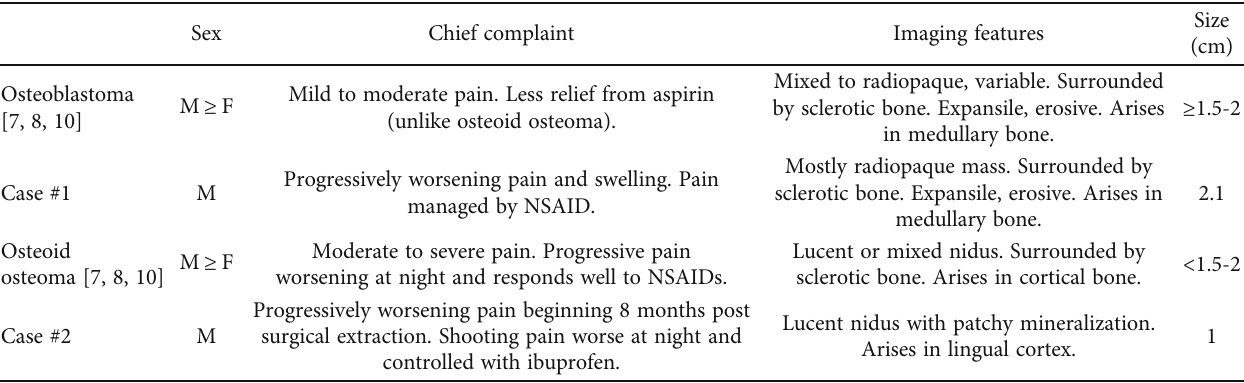
Figure 6: Histological features of case #1 (a and b). (a) Decalci fi ed bone with evident reversal lines with prominent osteoblastic activity. Note the vascular connective tissue stroma with dilated blood vessels and hemorrhage (H&E stain, × 40). (b) A higher magni fi cation of panel (a) showing the bone with prominent and large osteoblasts with abundant cytoplasm and epithelioid morphology (H&E stain, × 100). (c and d) Histological features of case #2. (c) Decalci fi ed bone with reversal lines with prominent osteoblastic activity. Note the vascular connective tissue stroma with dilated blood vessels and small foci of hemorrhage (H&E stain, × 40). (d) A higher magni fi cation of panel (c) showing the bone with prominent and large osteoblasts with abundant cytoplasm and vascular connective tissue stroma with dilated blood vessels and scattered erythrocytes (H&E stain, × 100). Table 1: Characteristics of osteoblastoma and osteoid osteoma as previously summarized [7, 8, 10] comparing to current